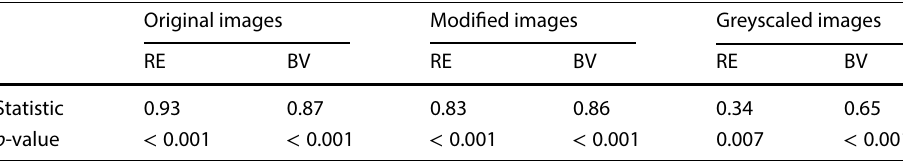
RE the reconstruction error approach, BV the bottleneck-values